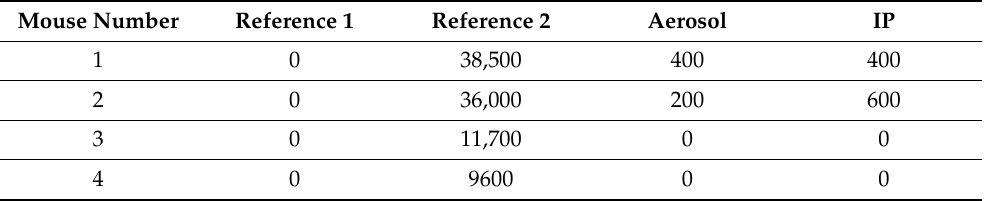
Table 9. The data of bacteriological examination an hour after the final introduction of the medicine